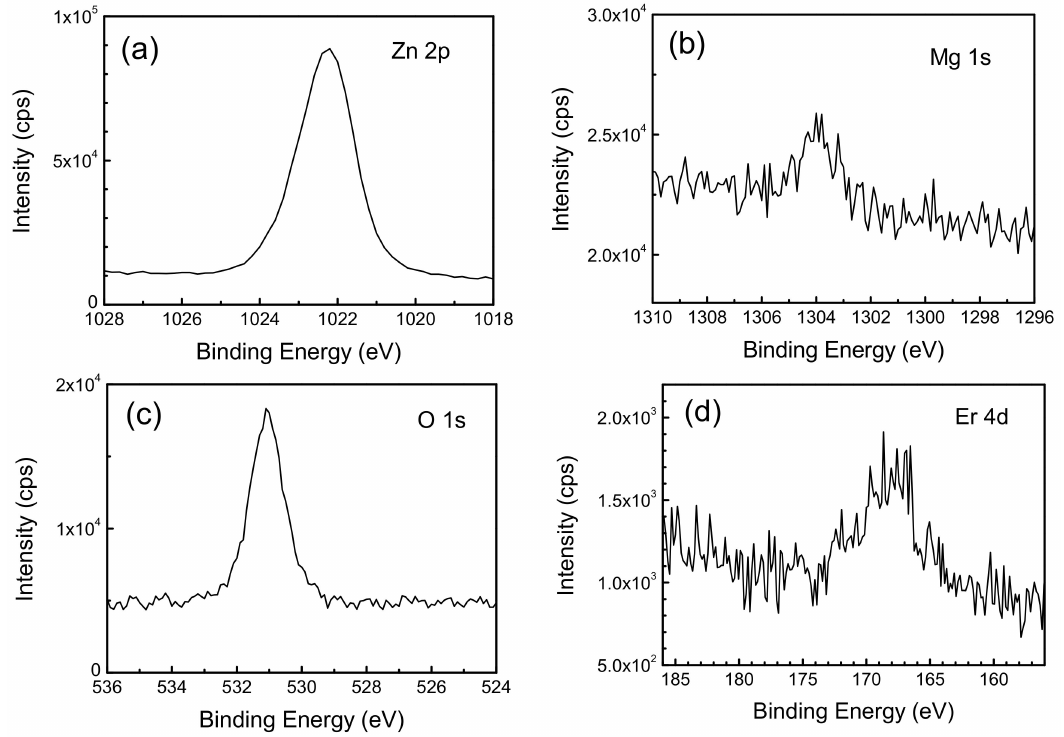
Figure 4. XPS spectra of ( a ) Zn 2p; ( b ) Mg 1s; ( c ) O 1s; and ( d ) Er 4d in the MgZnO:Er layer of sample ST3.